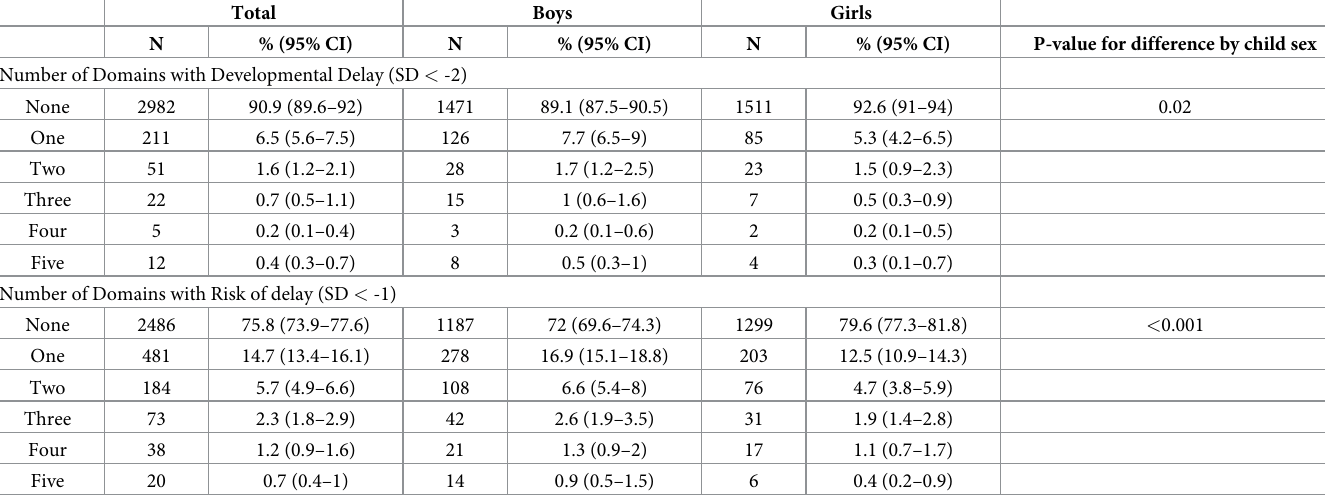
Table 3. Cumulative number of domains with developmental delay per child out of the five Ages and Stages Questionnaire domains (communication, gross motor, fine motor, problem-solving, and personal-social domains) overall and stratified by child